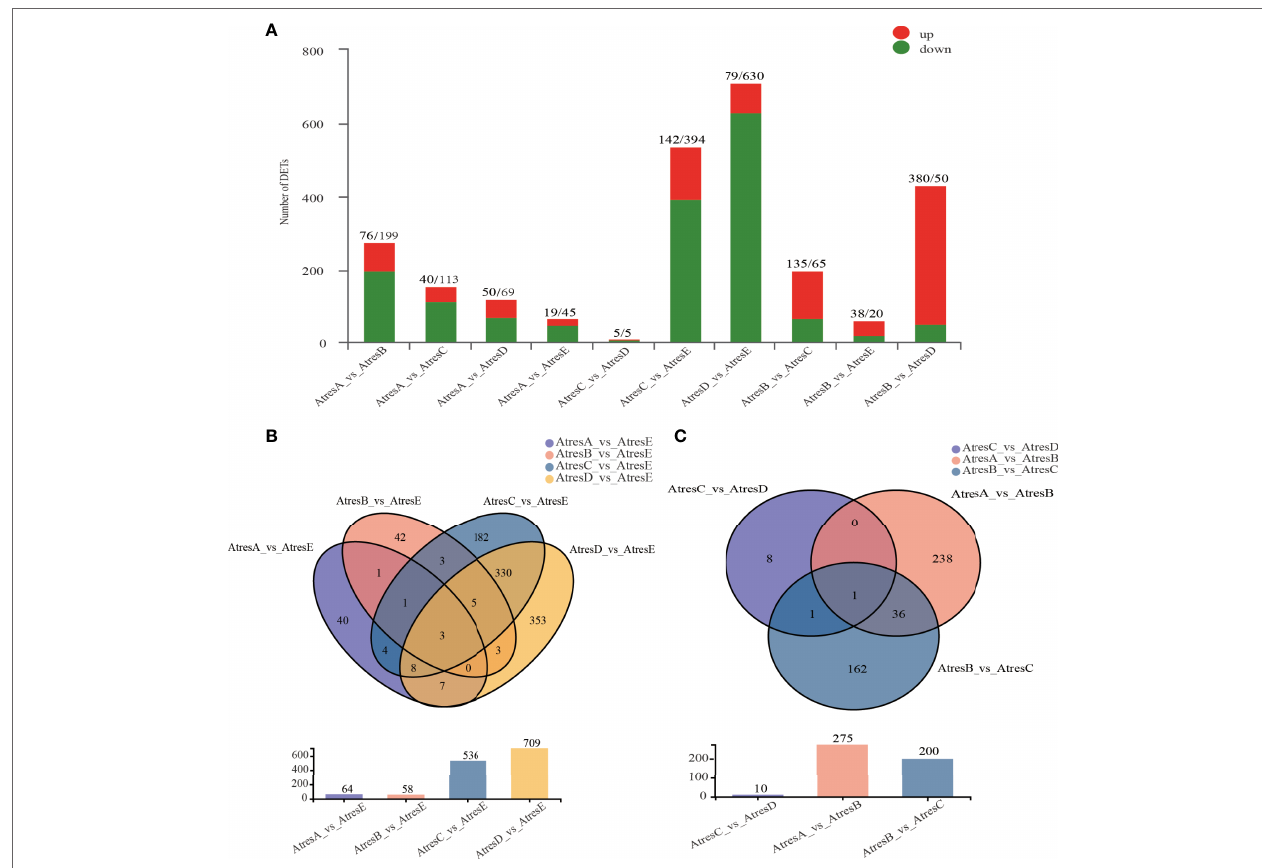
FIGURE 3 | DEGs between five stages. (A) DEGs between every two stages. (B) Venn diagram of DEGs in AtresA, AtresB, AtresC, and AtresD compared with AtresE. (C) Venn diagram of DEGs in AtresA vs. AtresB, AtresB vs. AtresC, and AtresC vs.